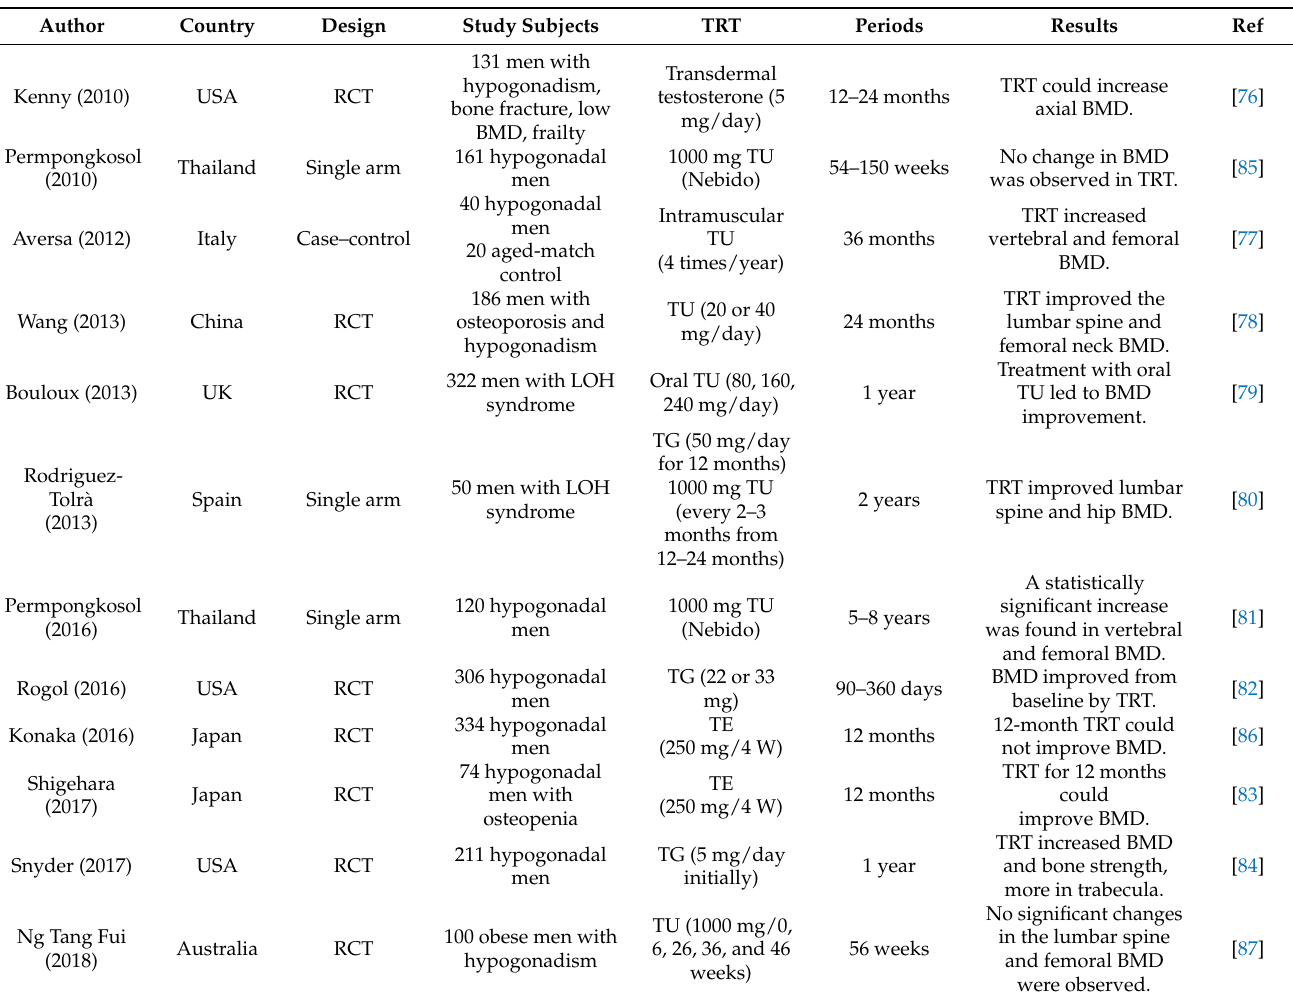
Table 4. The effects of TRT on BMD in hypogonadal men (from papers published since